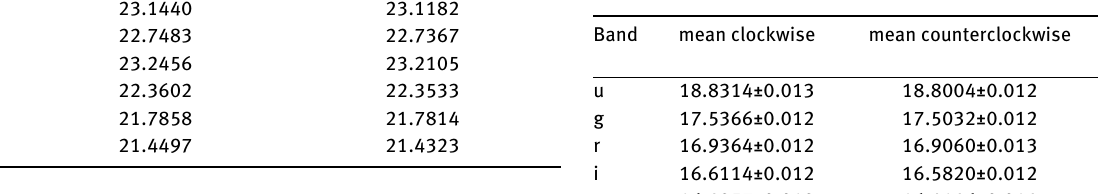
Table 5. Mean exponential magnitude of clockwise and counter- clockwise SDSS galaxies in the field centered at the COSMOS